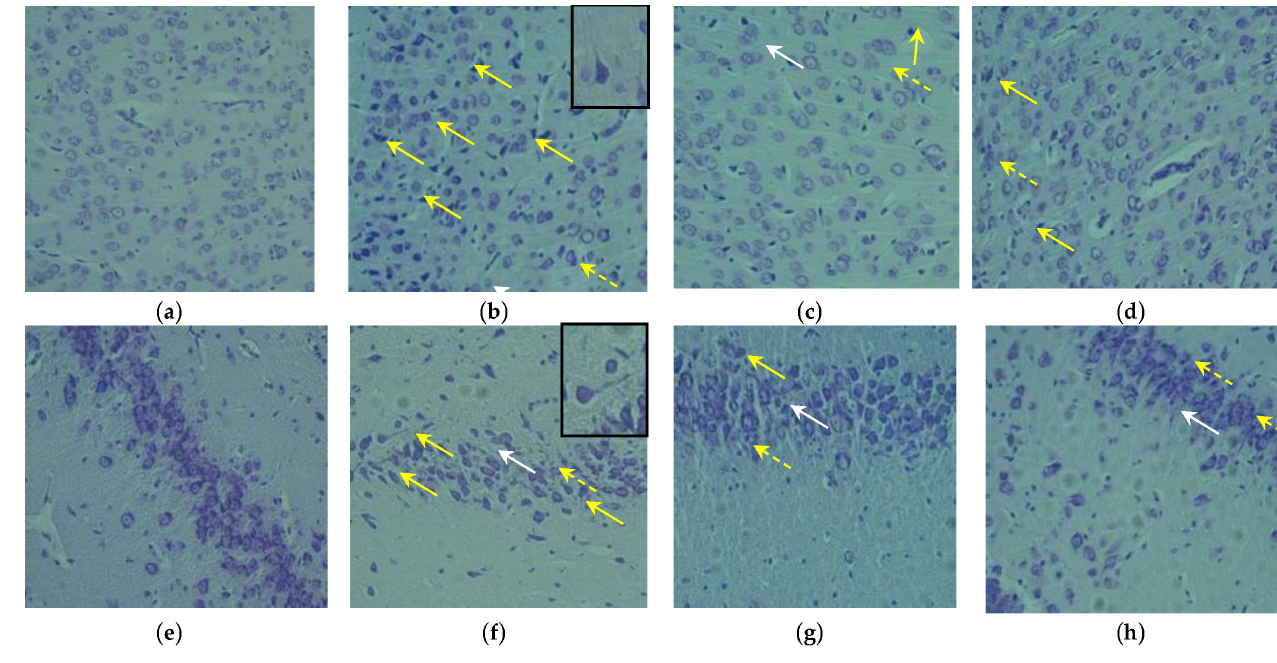
Figure 3. Cerebral cortex ( a – d ) and hippocampus ( e – h ) in rats with long-term scopolamine exposure: intact group ( a , e ), control group ( b , f ), K. centauroides (100 mg/kg; ( c , g )) and G. biloba (100 mg/g; ( d , h )). Stained with cresyl violet. Magnification ×200. Solid yellow arrow—pycnotic neurons; white arrow—cytolysis of neurons; yellow dotted arrow—satellite; in insets–thinning dendrites. There was perivascular edema as well as the phenomena of neuronophagia and Table 4. ATP content, of mitochondrial complexes I and II activity and of glycolysis indicators in the satellite disease. Single neuropil vacuolization, hyperchromatic and wrinkled nuclei, as rats’ brain with prolonged scopolamine exposure. well as an altered shape of the apical dendrites in a “corkscrew” form were observed in the neurons. In animals treated with K. centauroides extract, hyperchromic (pycnotic) neurons were much less common, in most cases, in layers III and V; “shadow cells” were